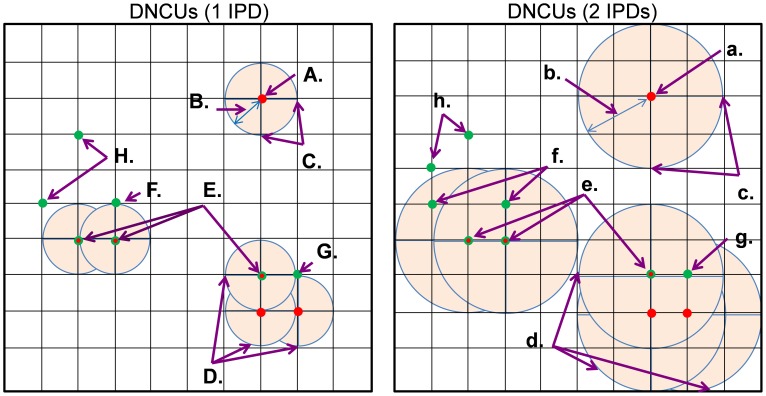
Schematic diagram of the blur algorithm with a dilated N-Cad unit (DNCU) radius of 1 inter-pixel distance (IPD) and 2 IPDs.
A&a. An N-Cad pixel at the center of a DNCU (C&c). Dilation radius equals to 1 IPD and 2 IPD (B&b). D&d. 3 overlapping adjacent DCNUs (R = 1 IPD & 2 IPDs, respectively) containing 3 adjacent N-Cad pixels. E&e. Three Cx43 pixels that are pixel-by-pixel matched with three N-Cad pixels, respectively. F-G & f-g. Two Cx43 pixels that do not co-localize with any N-Cad pixel-by-pixel but are included within the area of one of DCNU. All the DNCU covered Cx43 pixels (E-G & e-g) are defined as Cx43E-E. H&h. Two Cx43 pixels that are located outside of all DCNU covered areas and are therefore categorized as Cx43S-S.